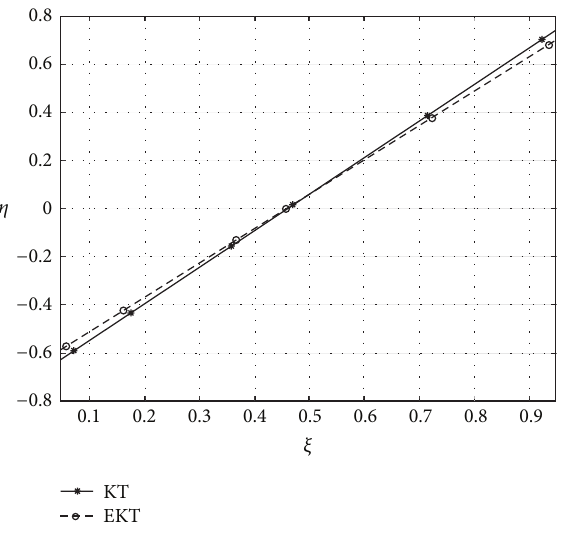
Figure 3: KT and EKT plot for APMA-EMA copolymerization.